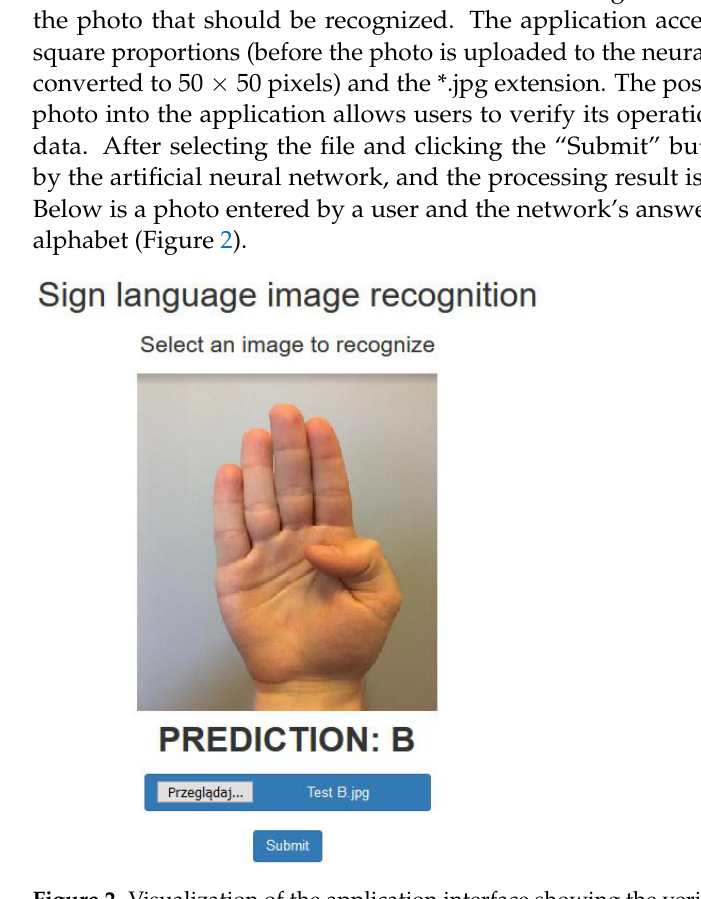
Figure 3. Loss function curve of the network learning process. The parameter that allows determination of the ability of the neural network to as- similate knowledge in the fastest and easiest way is the accuracy of the forecasts made. This is the quotient of the number of correctly recognized datapoints out of the total